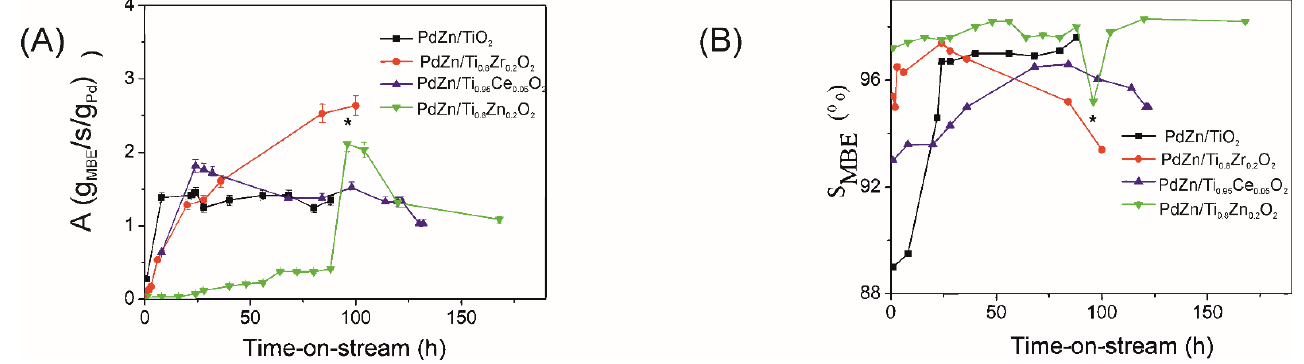
Figure 5. ( A ) Activity and ( B ) MBE selectivity vs. time on stream. *—air, 293 K, 240 h.